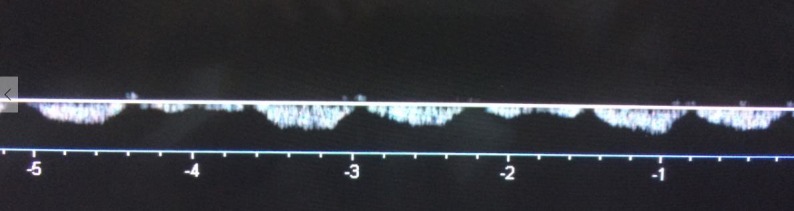
Pulsatile waves in the femoral vein.